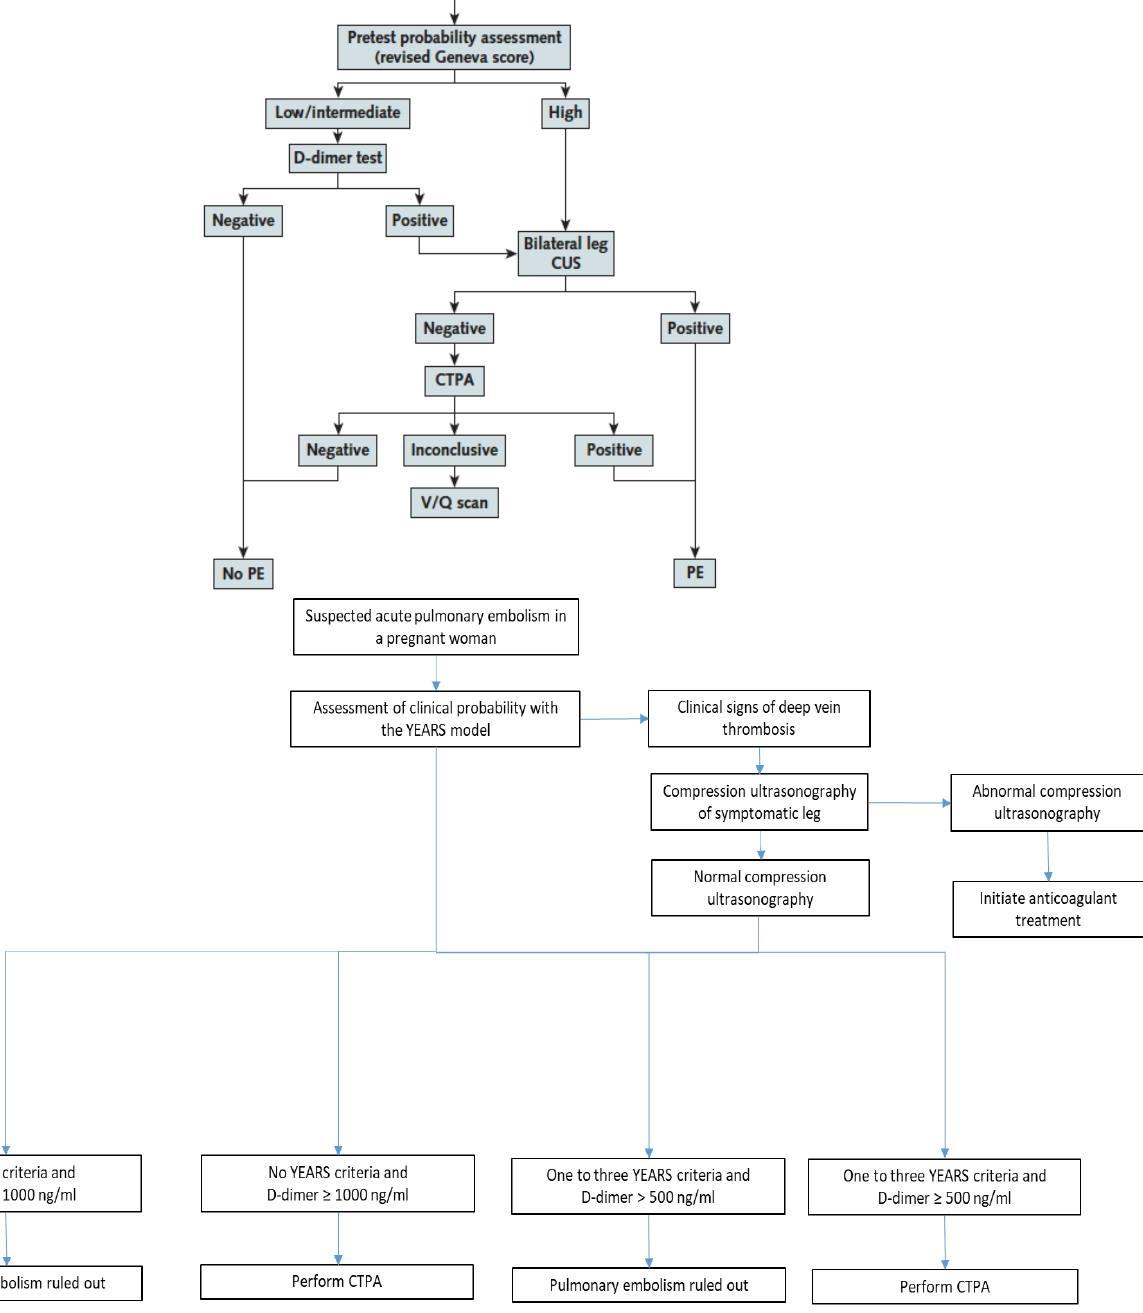
Figure 1. The CT-PE pregnancy and the pregnancy-adapted YEARS diagnostic algorithms [8,9]. External validation of the ARTEMIS model in the CT-PE pregnancy population con-